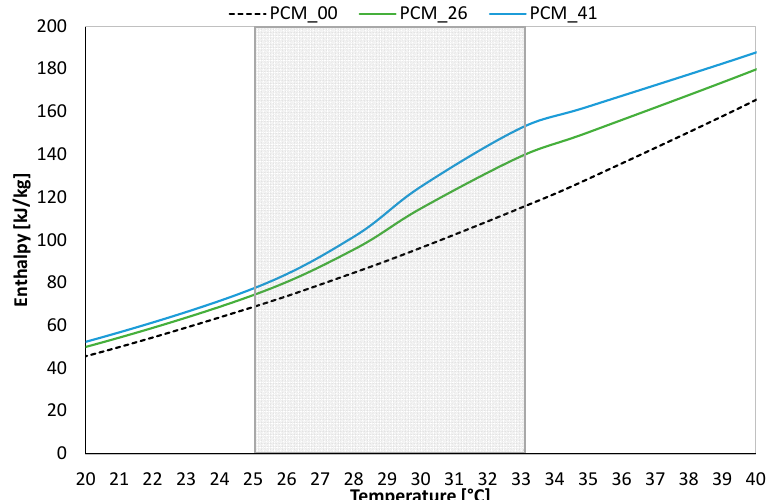
Figure 10. Enthalpy variation as a function of temperature for the three mixtures.